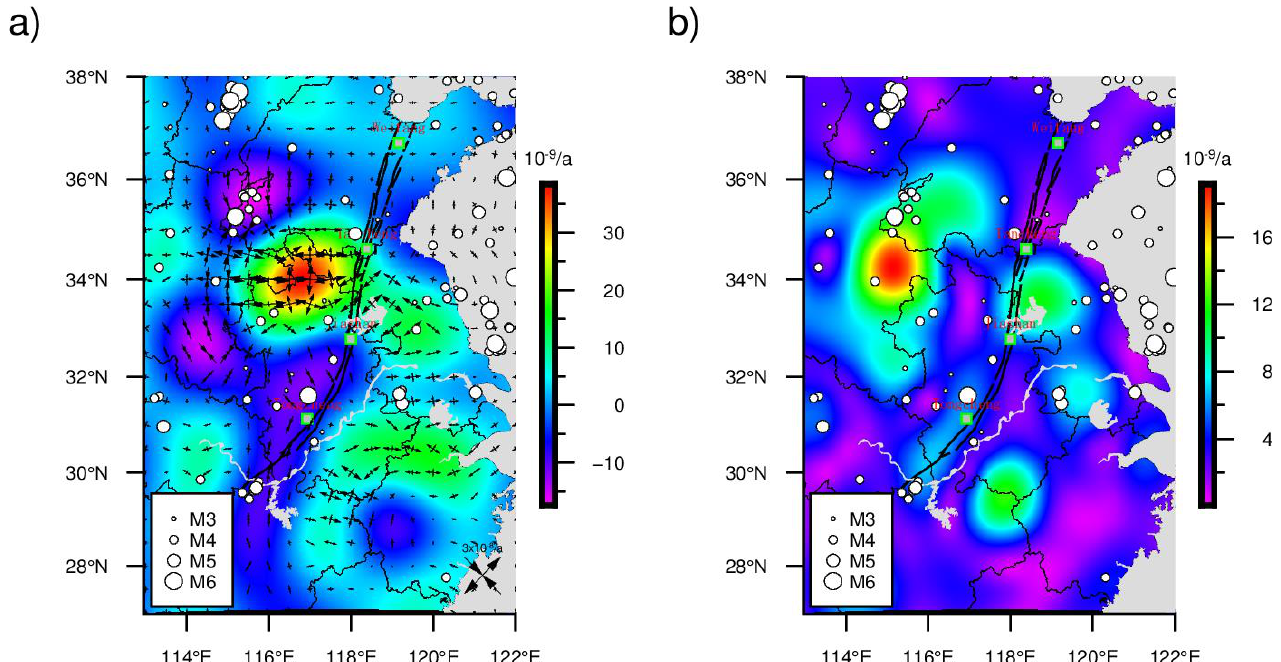
Figure 9. Strain rates on the central and southern segments of the Tanlu fault zone. ( a ) Principal strain rates and dilatation rates. Principle strain rates are shown as vector pairs and dilatation rates are shown in background color. Positive dilatation rates show extension, while negative show compression. ( b ) Maximum shear strain rates. White circles show earthquakes with 3.0 ≤ 𝑀 𝑠 ≤ 8.5